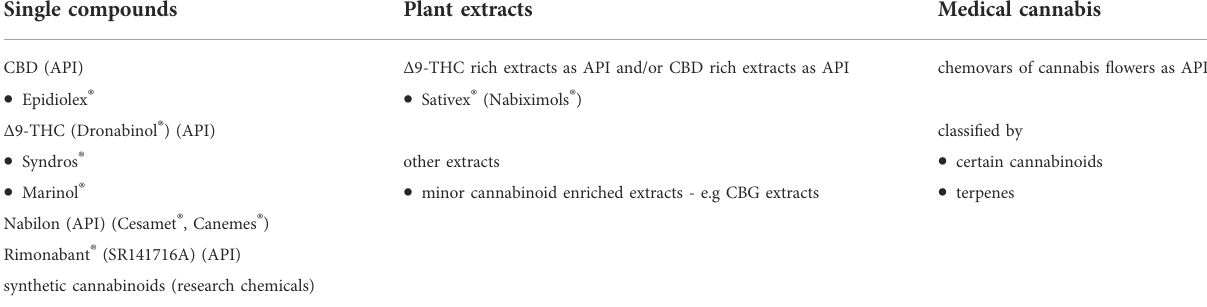
TABLE 2 Cannabinoid preparations and their respective source materials,